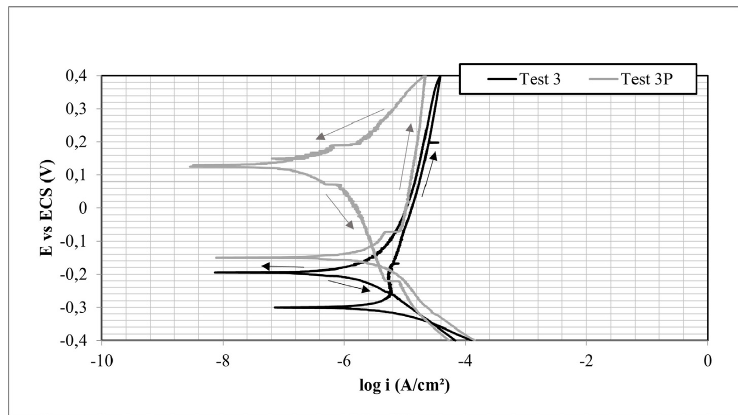
Figure 14. Cyclic voltammetric curves for tests 3 and 3P.